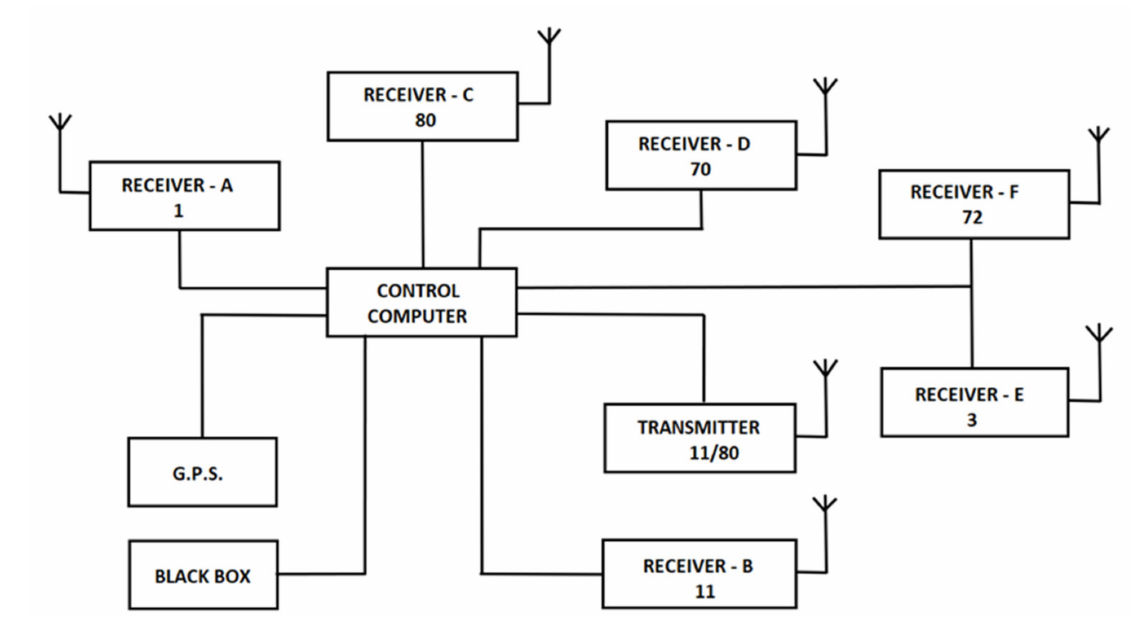
Figure 4. Block diagram of the system proposed for installation on board (AVISOMEF + Maritime Communication Network on Medium Frequency). The ship is assumed to be in the first cell, which is located to the left of the grid depicted in Figure 1. The receivers E and F operate in the upper grid of the same cell. The transmitter works for both AVISOMEF and the Communication Network